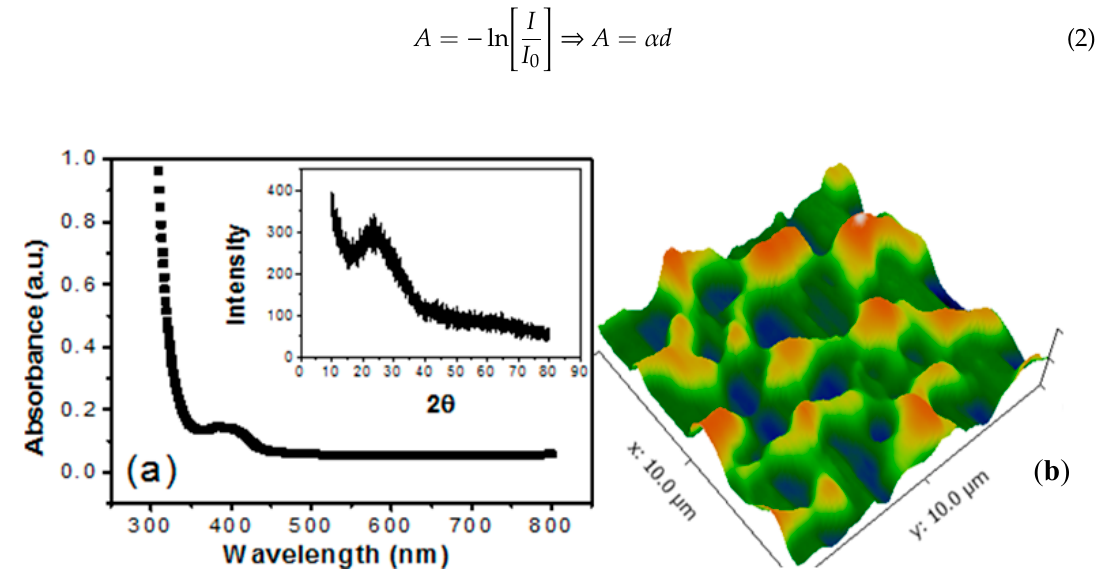
Figure 3. ( a ) UV-Vis spectrum; inset: XRD pattern and ( b ) AFM images of PFB:PCBM blended film.